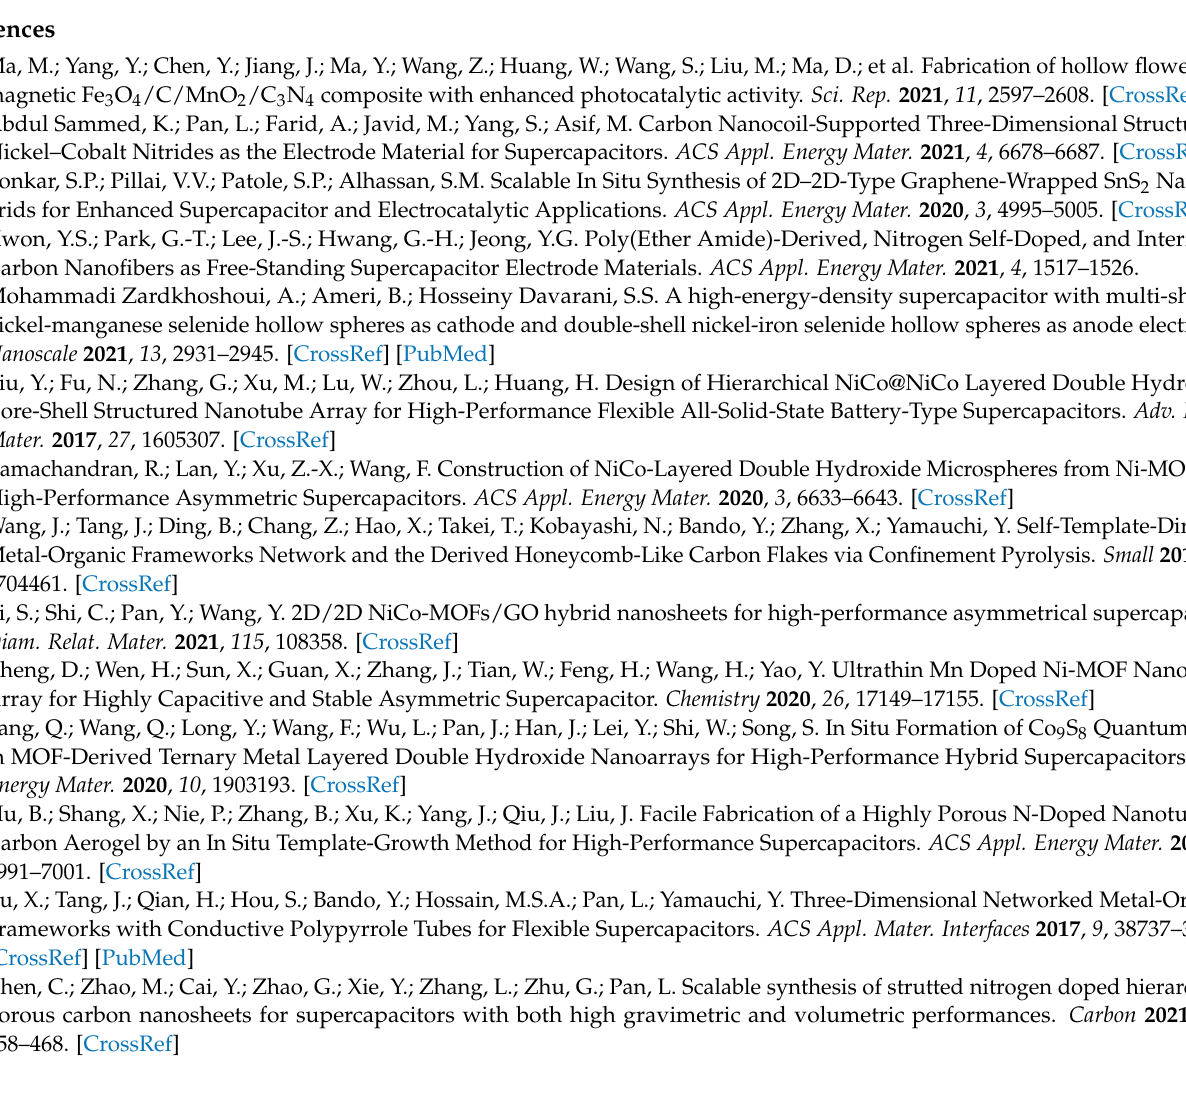
Figure S7: (a,b) SEM images of NiCo LDH/S-Ni MOF sample before and after 4000 cycles; Figure S8: Coulombic efficiency at current density of 5 Ag − 1